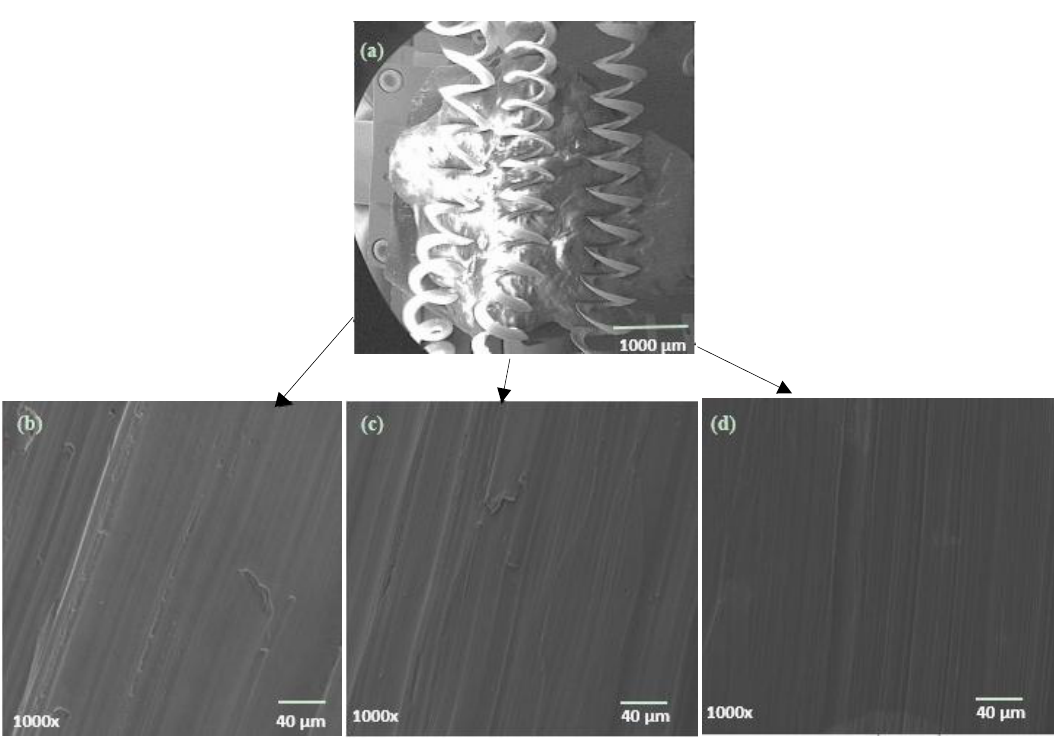
Figure 3. ( a ) General macrograph aspect of the chips, Chip undersurface obtained with ( b ) uncoated; ( c ) TiCN + Al 2 O 3 ; and ( d ) AlTiN carbide inserts.